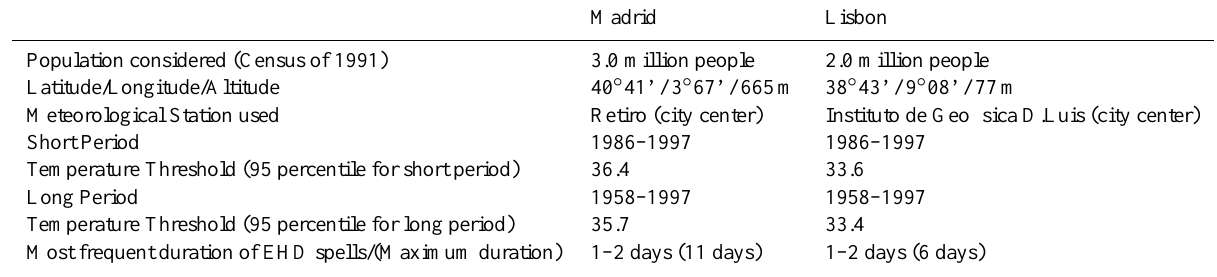
Table 1. Summary of main characteristics of data used from Lisbon and Madrid. Comparison of different variables between Madrid and Lisbon.